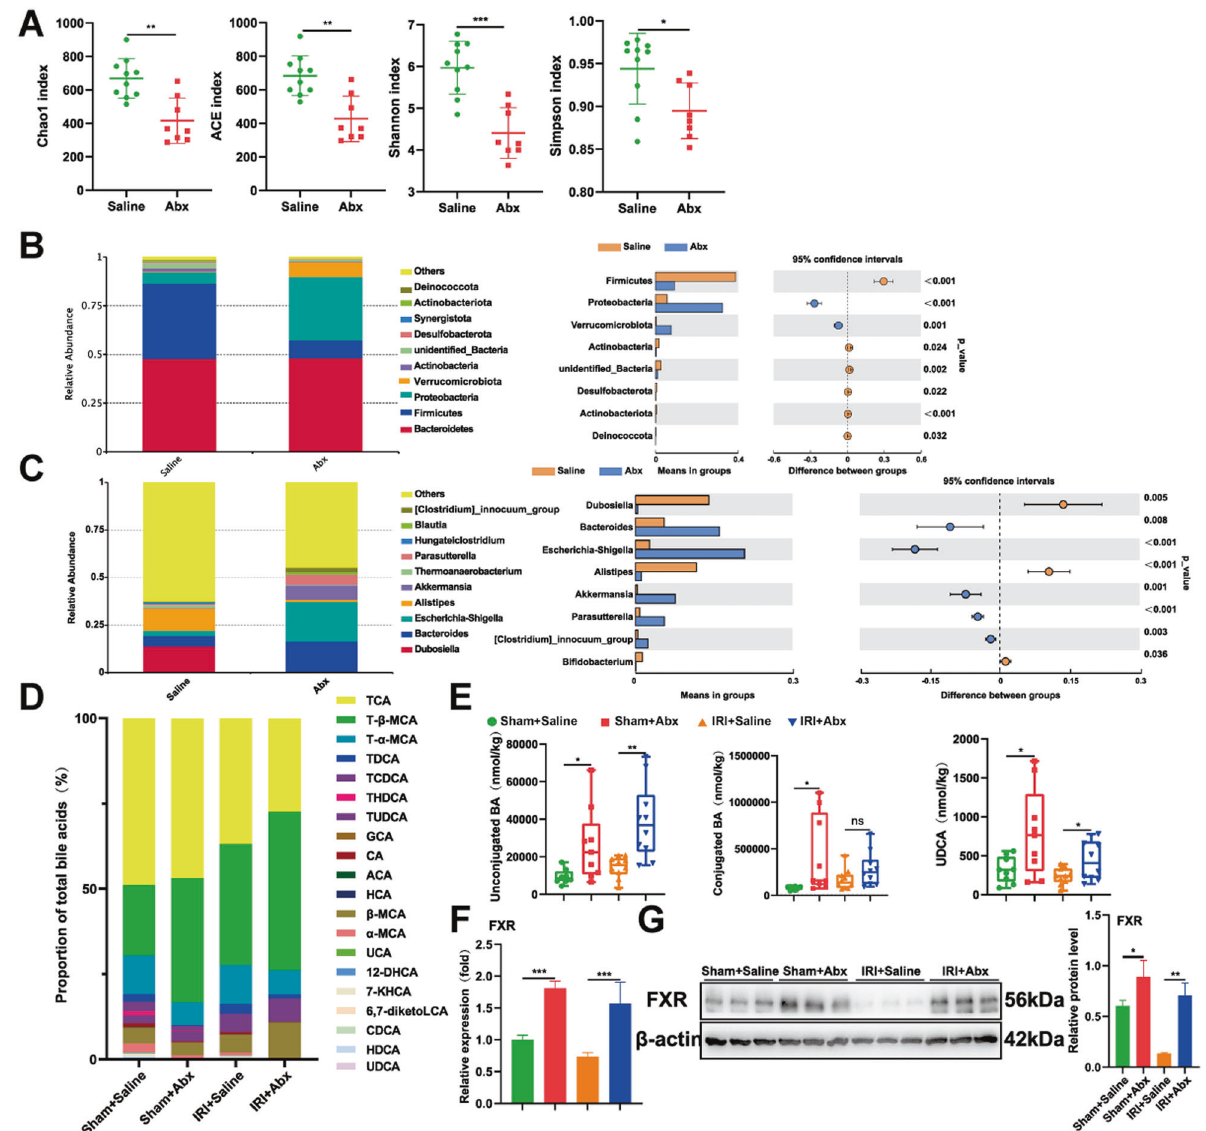
and unpaired Student ’ s t test ( E – G